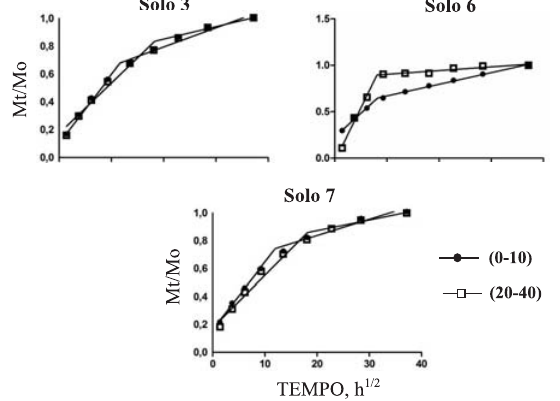
Figura 3. Cinética de liberação de Pb [equação parabólica de difusão (Mt/Mo = a + kt 1/2 )] das amostras de solos contaminadas com material particulado oriundo das chaminés da fábrica, em área localizada no município de Adrianópolis-PR.